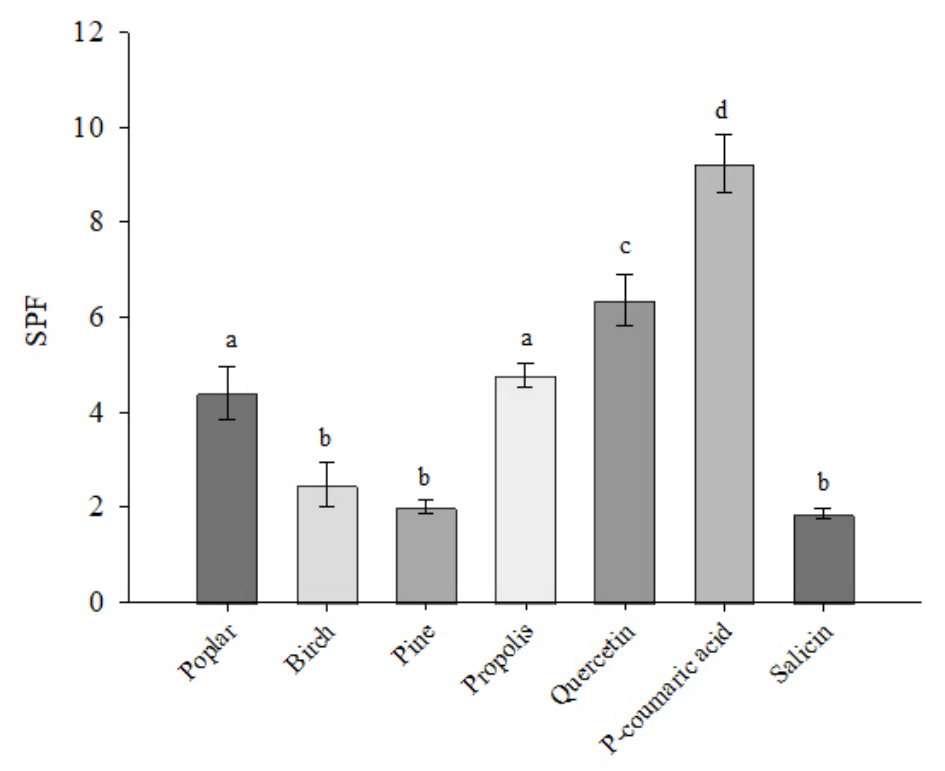
Figure 4. SPF values of poplar, birch, pine buds and propolis extracts by spectrophotometric method. Results are presented at extract concentrations of 10 µ g CAE/mL, standards of quercetin, p -coumaric acid and salicin at 10 µ g/mL. Subscripts of different letters symbolize a statistically significant difference between samples ( p < 0.05). Table 3. Correlation table comparing SPF factor (SPF), antioxidant activity (IC50 ABTS and IC50 DPPH ), total phenolic compounds (TPC), total identified phenolic acids (sum_TPA), total identified flavonoids (sum_F) and total identified active compounds